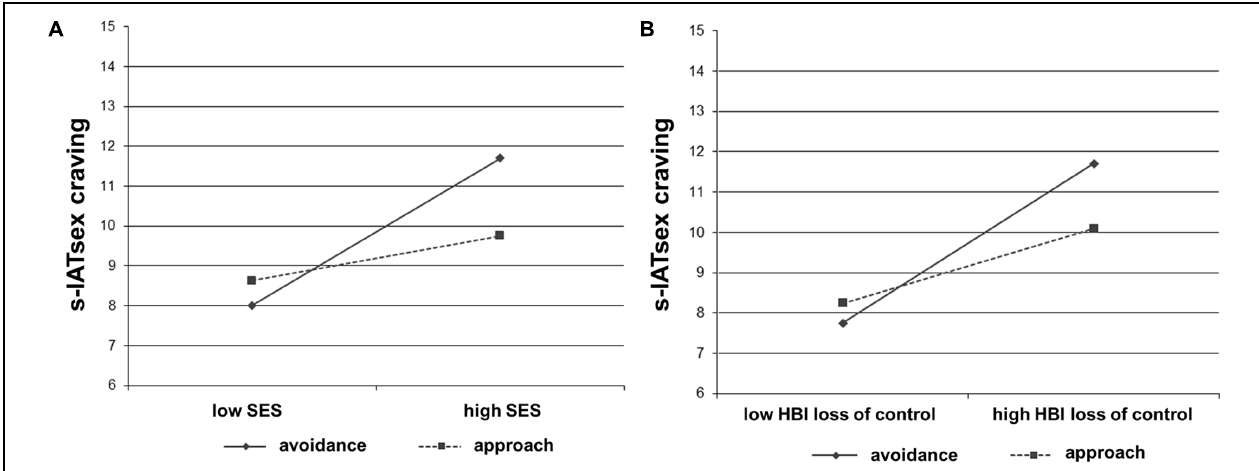
FIGURE 3 | Graphical illustration of simple slopes with respect to the interactions between the compatibility effect for pornographic pictures (pornographic approach/avoidance score) and (A) the sensitivity toward sexual excitation (SES) as well as (B) problems controlling sexual behavior (HBI loss of control).